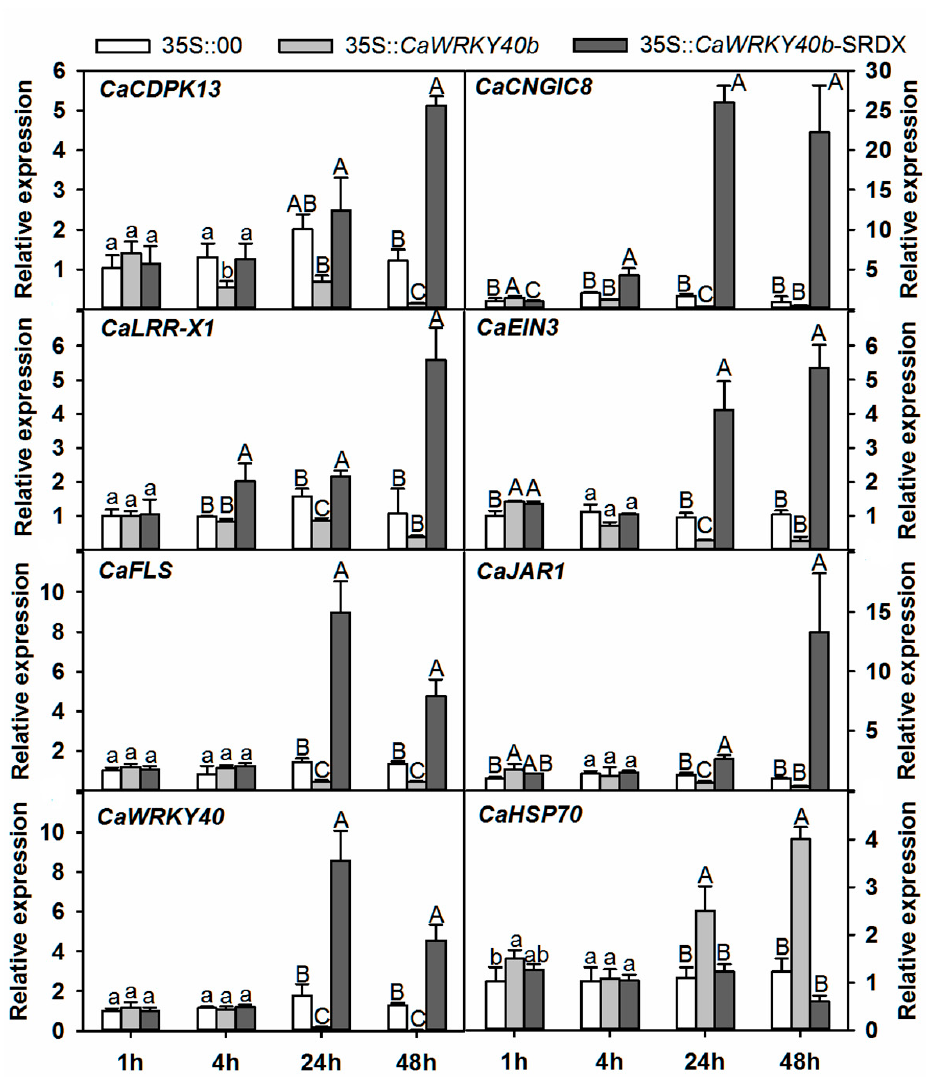
Figure 6. qRT-PCR analysis of the expression of immunity-associated marker genes in 35S::00 , 35S::CaWRKY40b and 35S::CaWRKY40b-SRDX constructs. Data display the means ± SD of four independent biological replicates, each containing three leaves. Capital and lowercase letters above the bars indicate significantly different means ( p < 0.01) and significantly different means ( p < 0.01), respectively, as analyzed by Fisher’s protected LSD test.